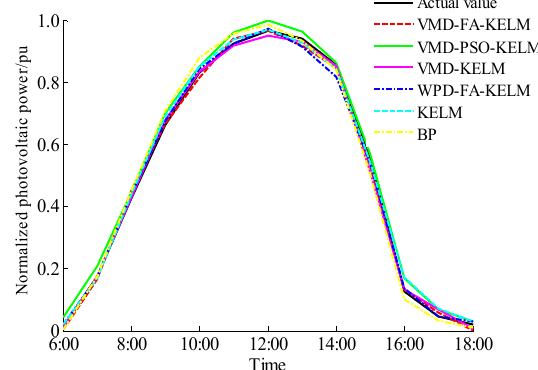
Figure 8. Point prediction of the sunny day under different optimization algorithms.